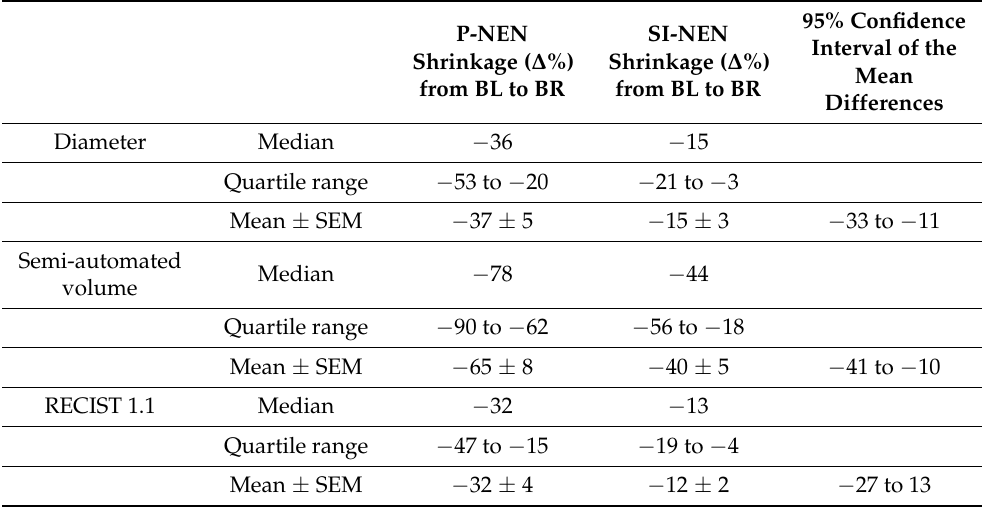
Table 3. Fractional shrinkage ( ∆ %) in P-NENs and SI-NENs from baseline (BL) to best response (BR) regarding tumor diameter, semi-automated tumor volume and RECIST 1.1